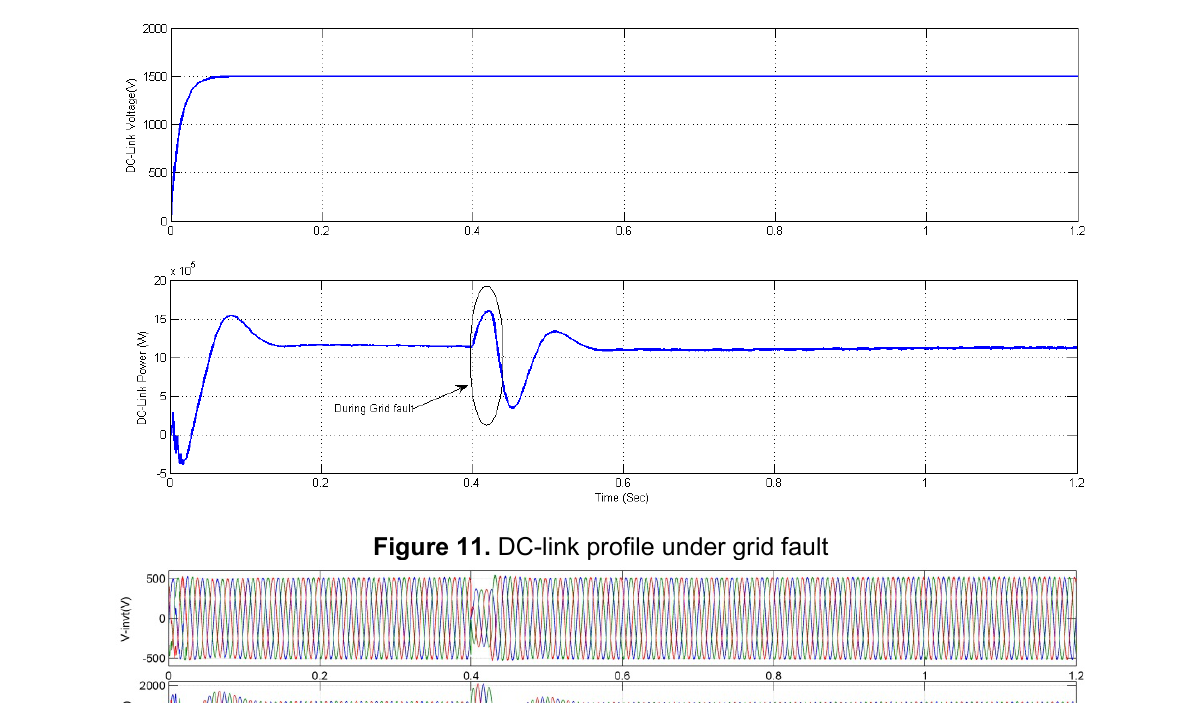
Figure 11. DC-link profile under grid fault